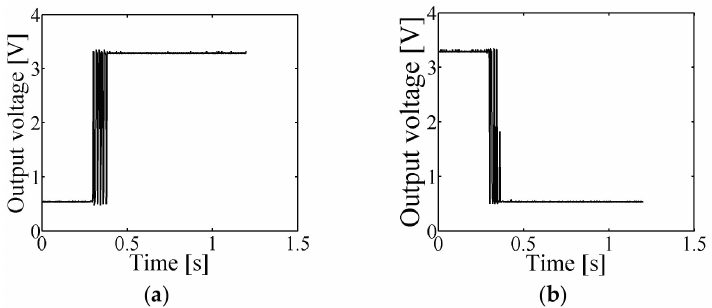
Figure 11. The flame detection sensor working. ( a ) The flame detector output signal when the flame is turned on. The stabilization time is around 100 ms; ( b ). The flame detector output signal when the flame is turned off. The stabilization time is around 60 ms.